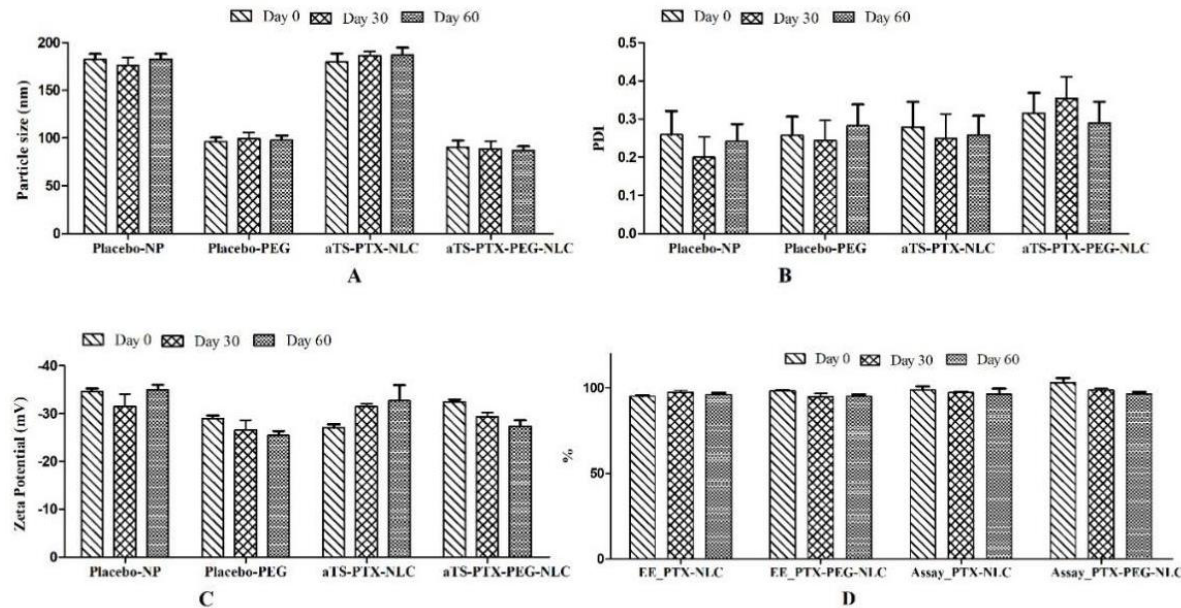
Figure 8. Stability studies for α TS-NLC (F5) formulation stored at 4 °C for up to 60 days (last time point measured). ( A ) Particle size, ( B ) PDI, ( C ) Zeta potential, ( D ) Entrapment Efficiency and Assay.